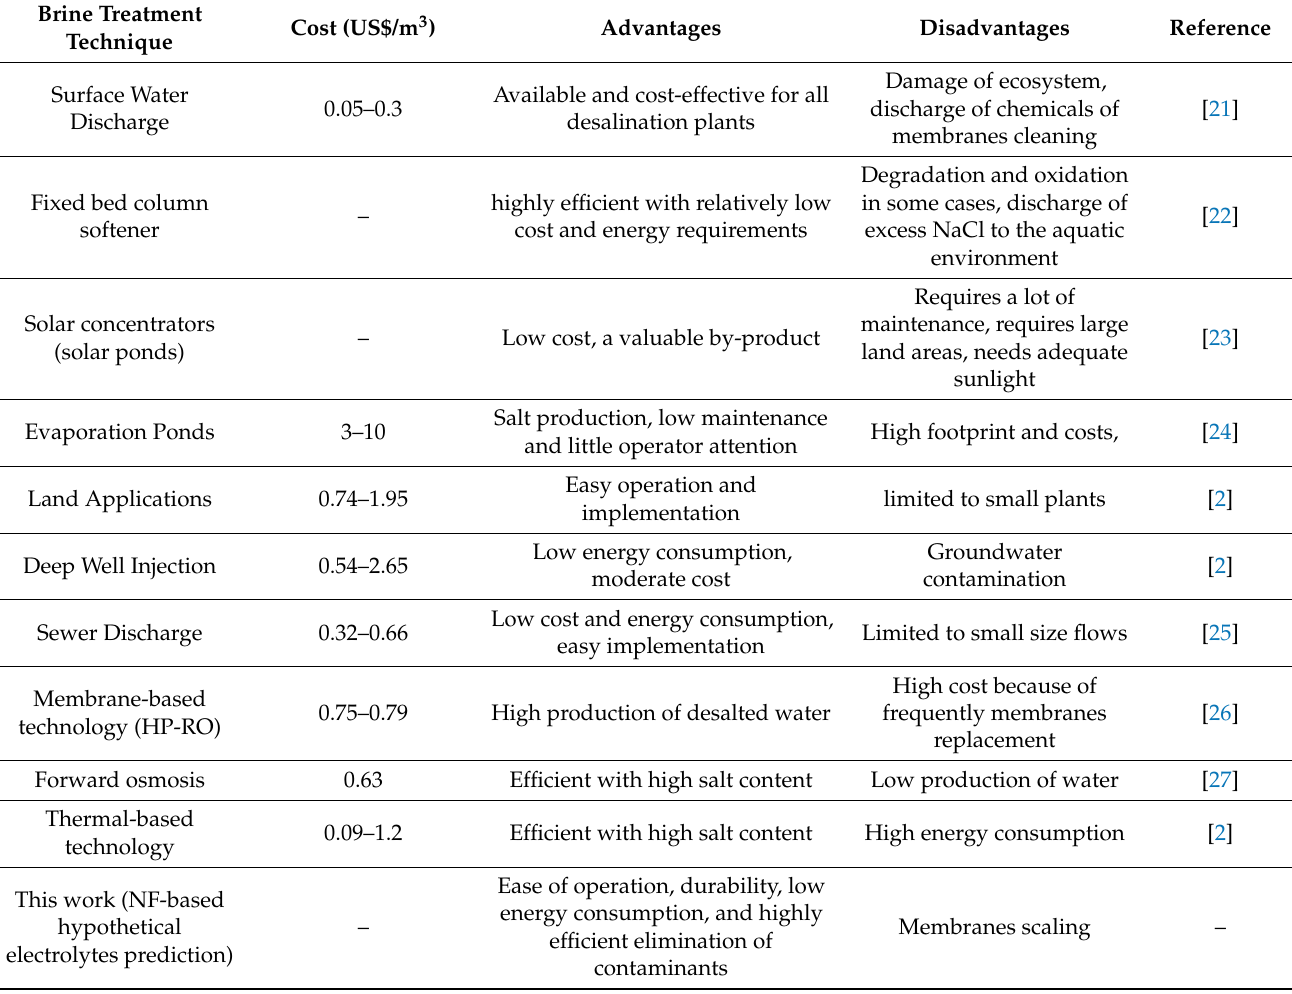
Table 1. Different technologies of RO-brine